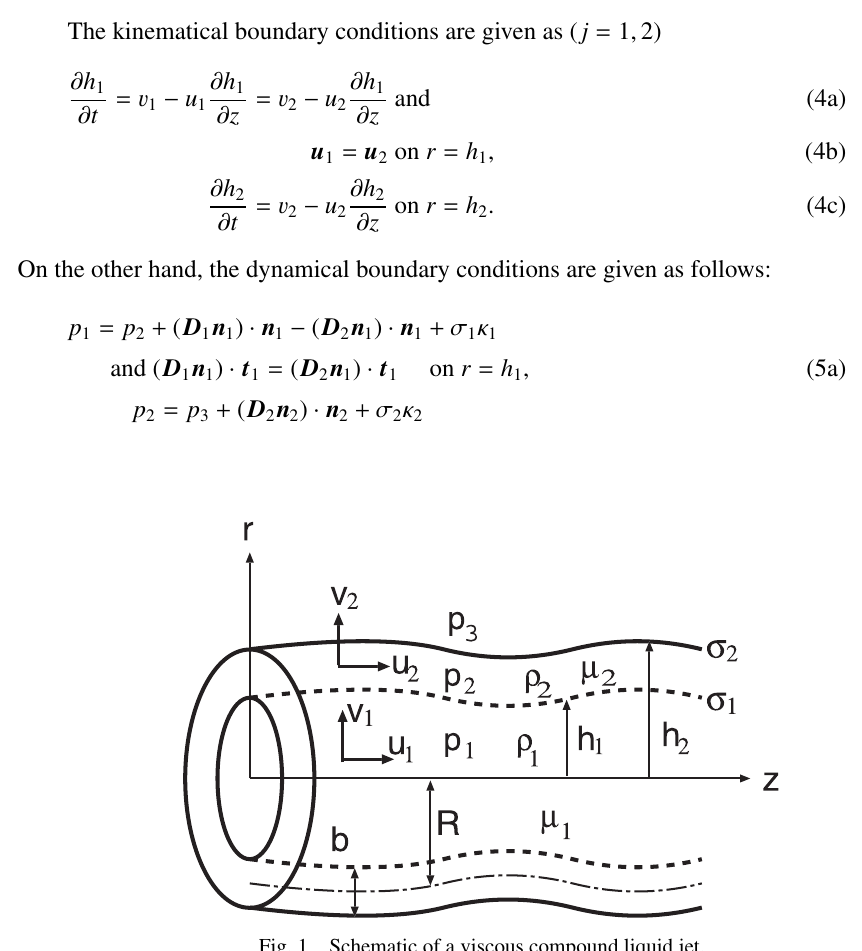
Fig. 1 Schematic of a viscous compound liquid